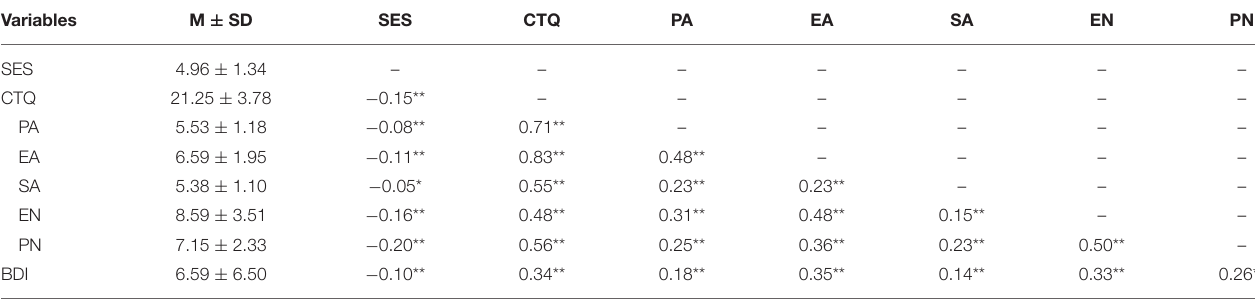
TABLE 2 | Correlations among SES, CTQ-SF, the different forms of CTQ-SF, and BDI ( N = 1,807). Variables